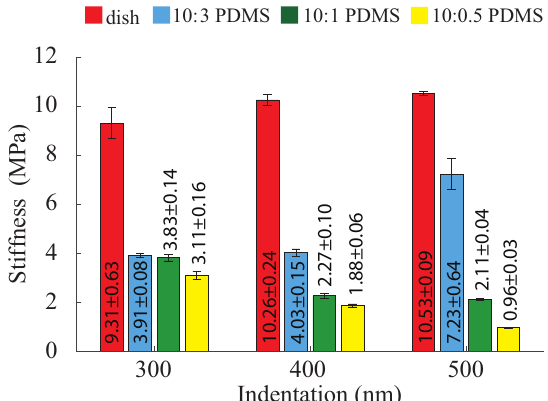
Figure 2. Stiffness nonlinearity of the four different substrates measured at the indenting velocity of 20 µ m/s. The error bars represent the standard errors. n = 6. Student’s t-test was performed to analyze the statistical difference: for each indentation, data were compared with respect to the ones measured on the dish (control) at the same indentation; and for each substrate, the data measured at the minimum indentation (650 nm) for that substrate were chosen as control. A p < 0.05 was yielded for each comparison unless otherwise denoted in the figure (with p values in red bold italic